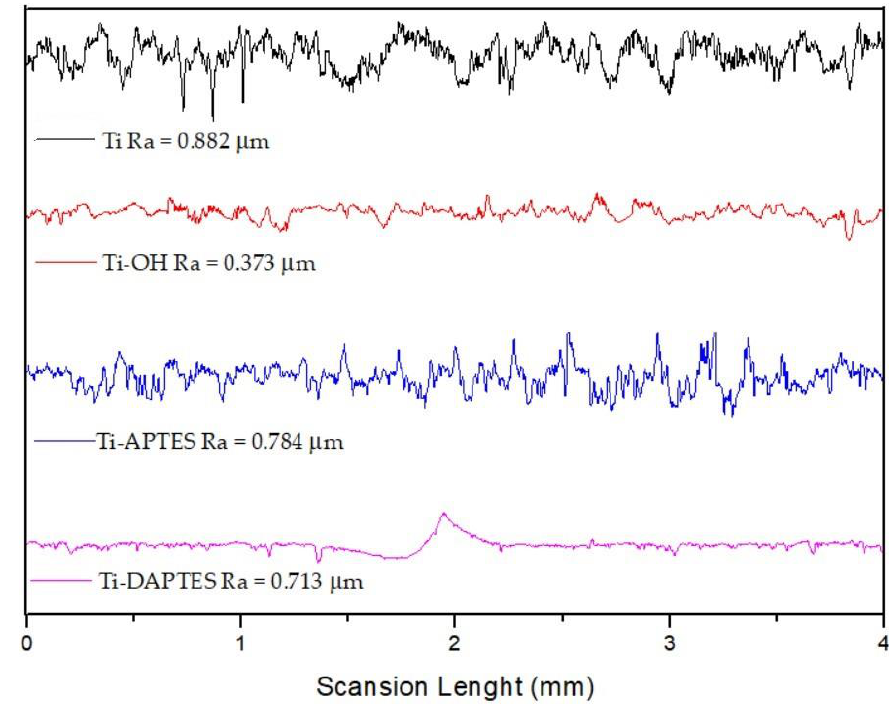
Materials 2022 , 15 , x FOR PEER REVIEW